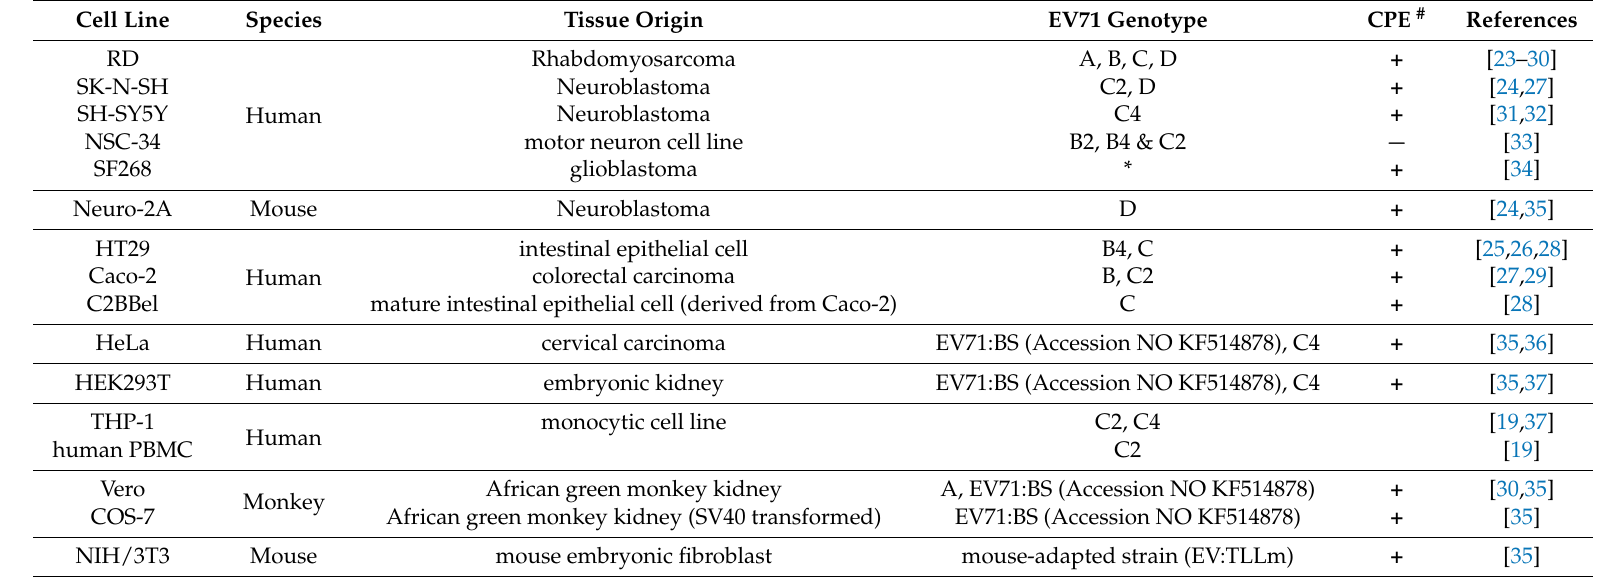
Table 1. Summary of 16 cell lines used for EV71 in vitro